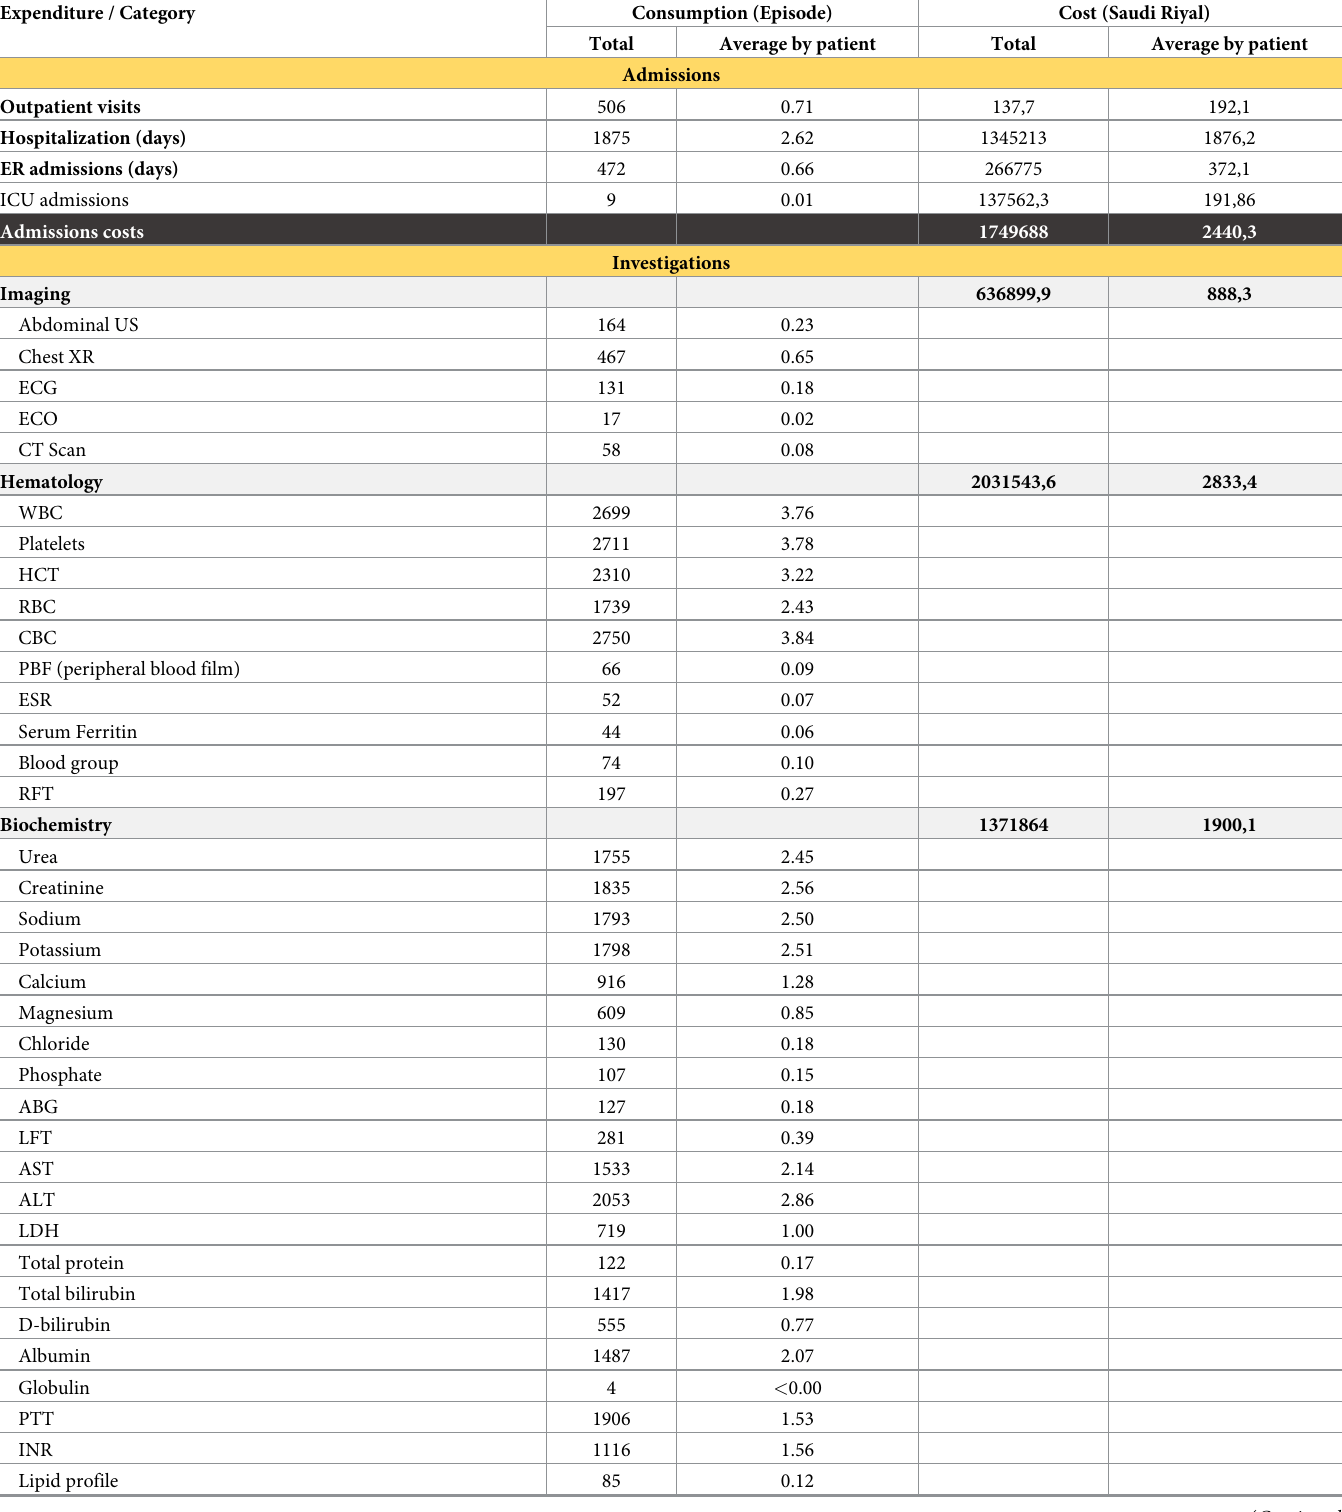
Table 3. Health consumption and costs in a representative sample of confirmed dengue patients from a selection of Jeddah hospitals (Source database, N =